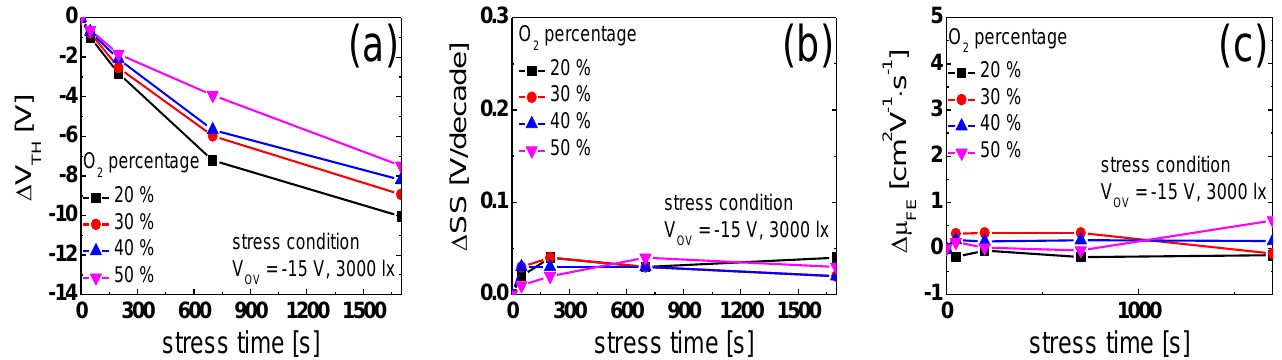
Figure 6. Time dependences of ( a ) ΔV TH , ( b ) ΔSS, and ( c ) Δ μ FE values obtained from the IGTO TFTs prepared at different oxygen percentages under NBIS after every stress time.